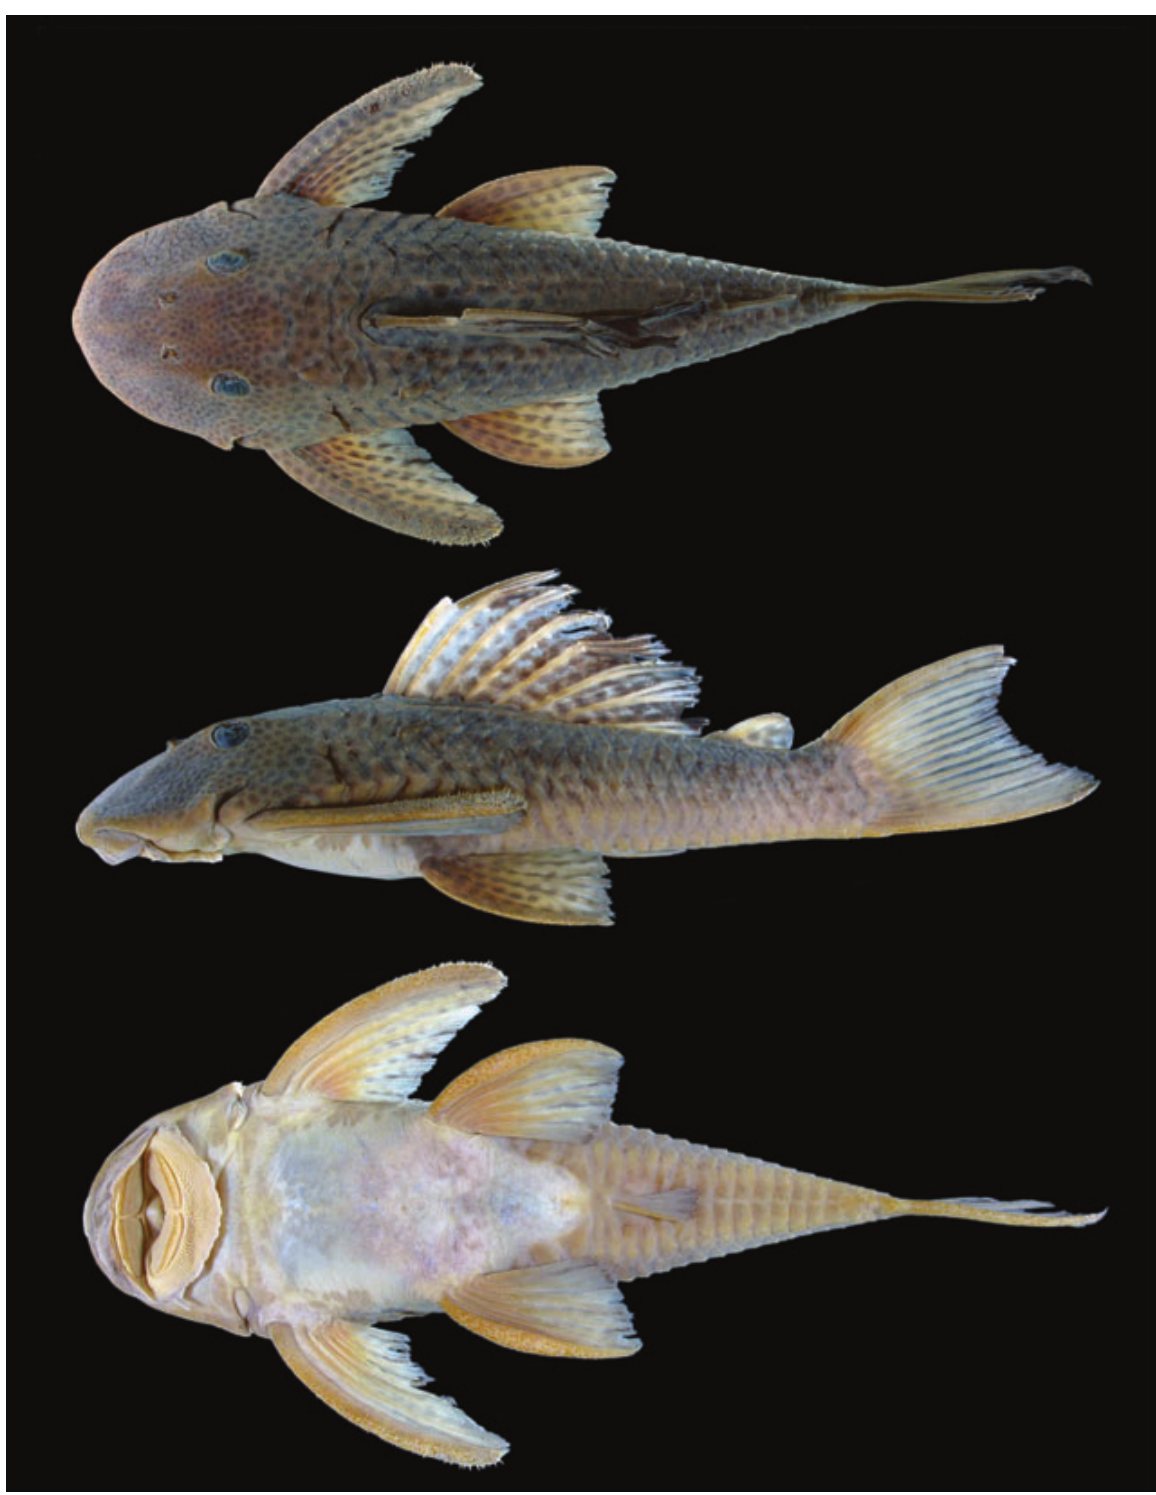
Fig. 1. Hypostomus kuarup , holotype, MZUSP 109765, 157.0 mm SL: Brazil, Mato Grosso, Campinápolis,